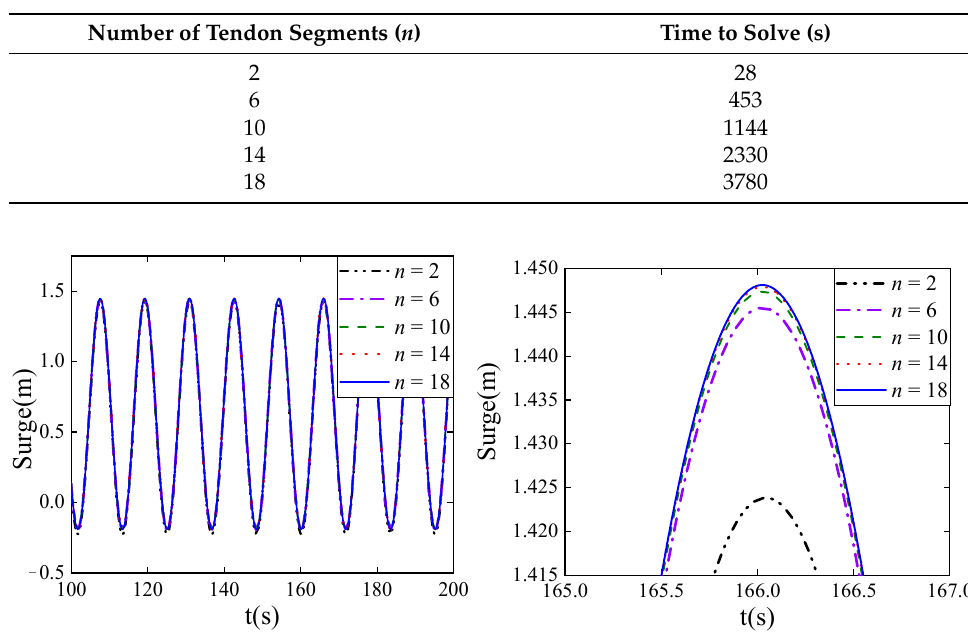
Figure 5. Calculated results of DUTMST 2.0 with different numbers of tendon